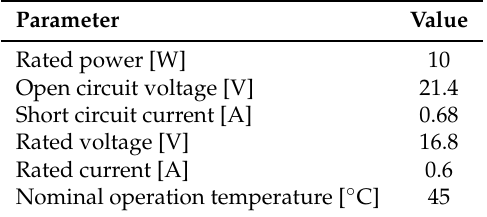
Table 9. Technical parameters of PS10M-12/B PV module.